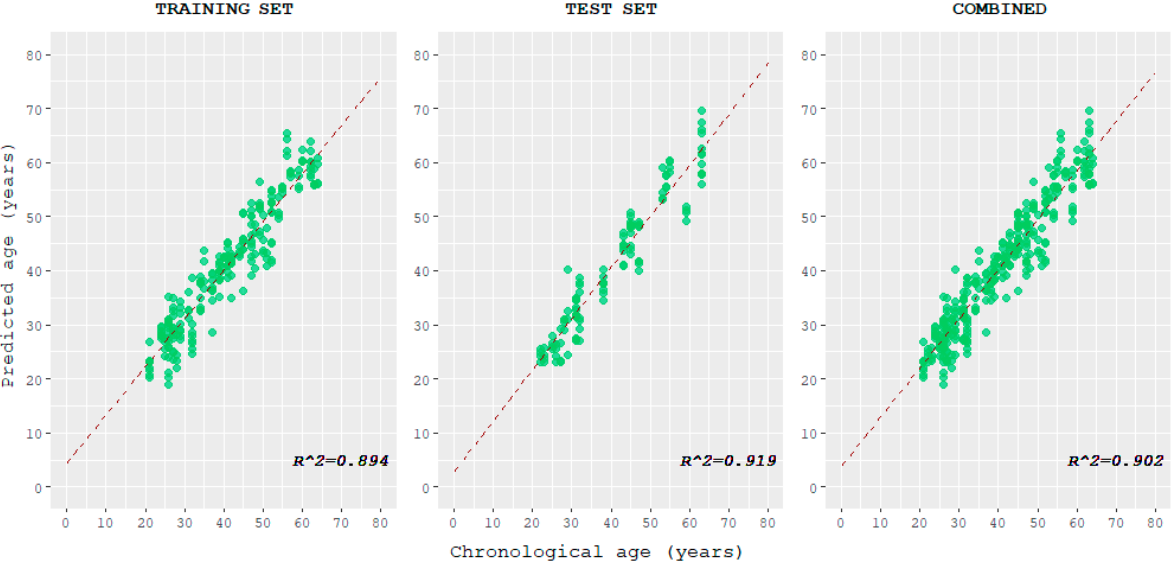
Figure 4. Scatterplots displaying the correlation between the age predicted using the tool here described and chronological age, for training, test, and combined datasets.